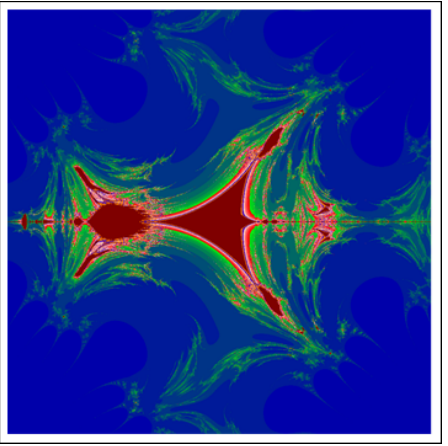
Figure 56. Tricorn via F-iteration with image visual time = 225.9 s.